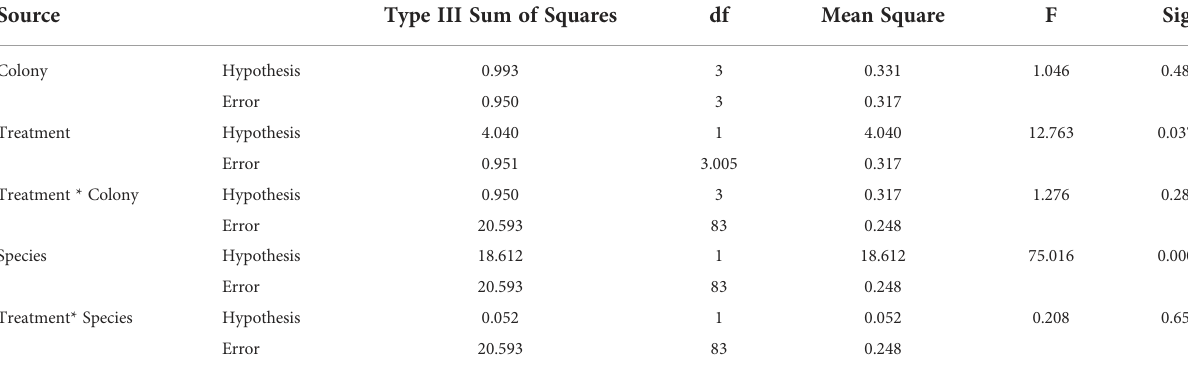
TABLE 1 ANOVA table for the split-plot design on growth rate of braching coral. * indicates p< 0.05.